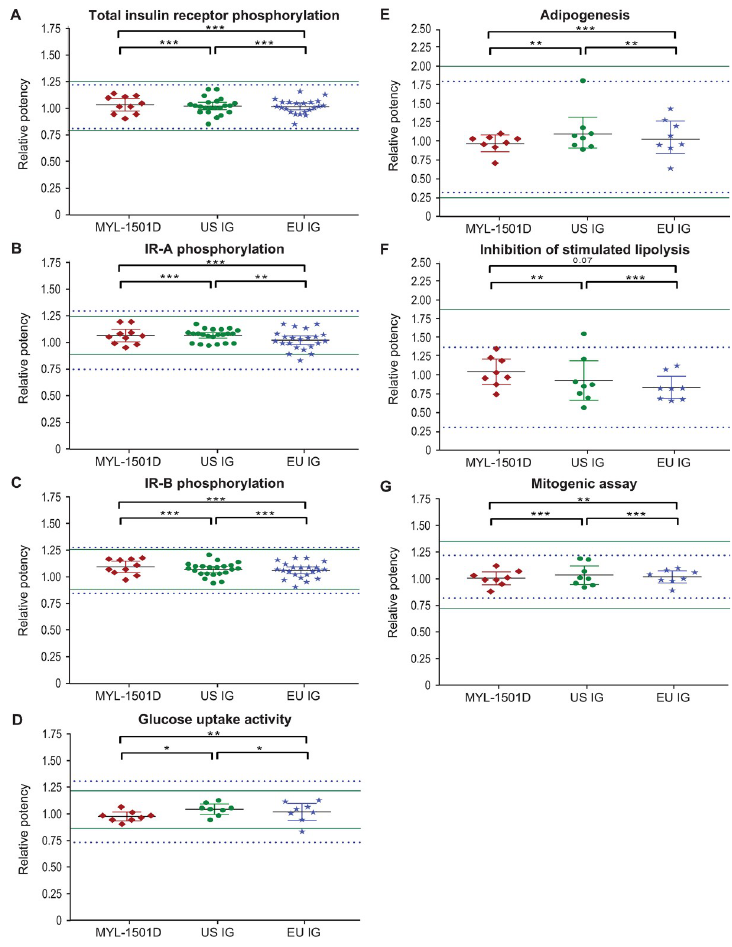
Fig 12. Scatter plot distribution of average relative potency of MYL-1501D, US- and EU-licensed insulin glargine. (A) IR Phosphorylation in HepG2 Cells, (B) IR-A Phosphorylation in CHO-K1 Cells Expressing IR-A, (C) IR-B Phosphorylation in CHO-K1 Cells Expressing IR-B, (D) Glucose Uptake Activity in 3T3-L1 Cells, (E) Adipogenicity Activity in 3T3-L1 Cells, (F) Inhibition of Stimulated Lipolysis Activity in 3T3-L1 Cells, and (G) Mitogenic Activity by Saos-2 Cells. Multiple lots of MYL-1501D, US-, and EU-licensed insulin glargine were analyzed, and data are expressed as mean ± 95% CI. Each dot represents one lot for which data were collected from 3 independent runs, and mean is presented. Mean ± 3 SD range derived from innovator product is presented as solid green line for US-licensed insulin glargine and dotted blue line for EU-licensed insulin glargine. � P < 0.05, �� P < 0.01, and ��� P < 0.001 in TOST/ Equivalence test. CHO, Chinese hamster ovary; GOPOD, glucose oxidase/peroxidase; IR, insulin receptor; Saos-2, sarcoma osteogenic cell; TOST, Two One-Sided T-test.